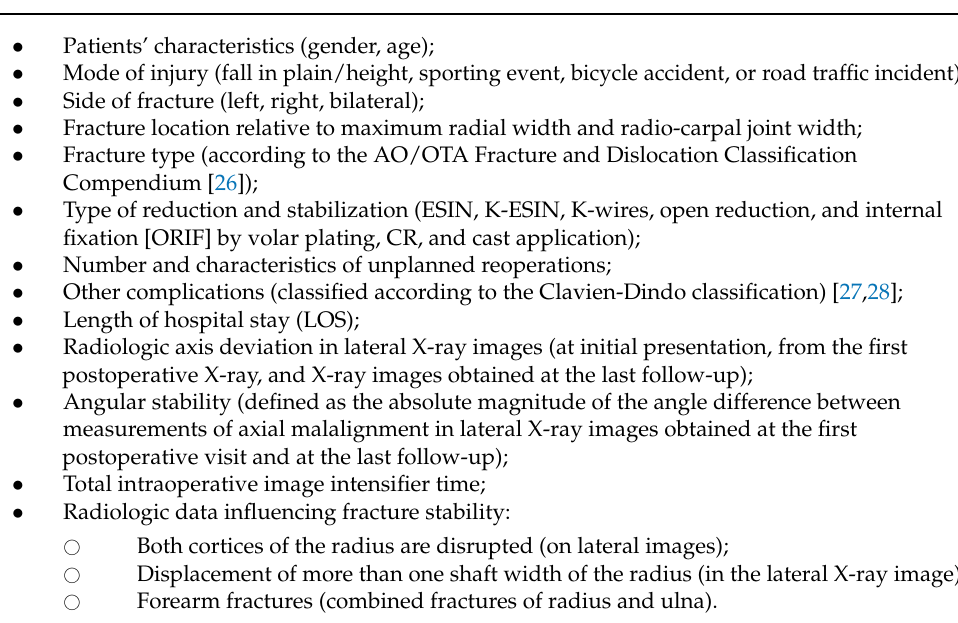
Figure 1. Definition of the diametaphyseal transition zone. Table 1. Patient data